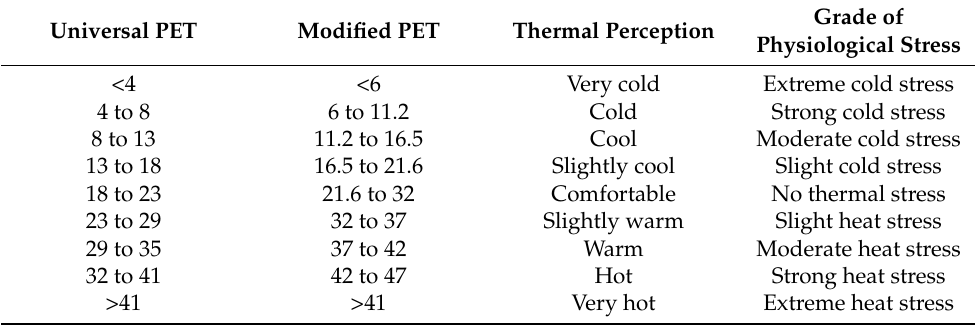
Table 3. The universal physiological equivalent temperature (PET) [42] and the modified PET range for Konya, Turkey. Based on Equation (1). Edited from ref. [53].